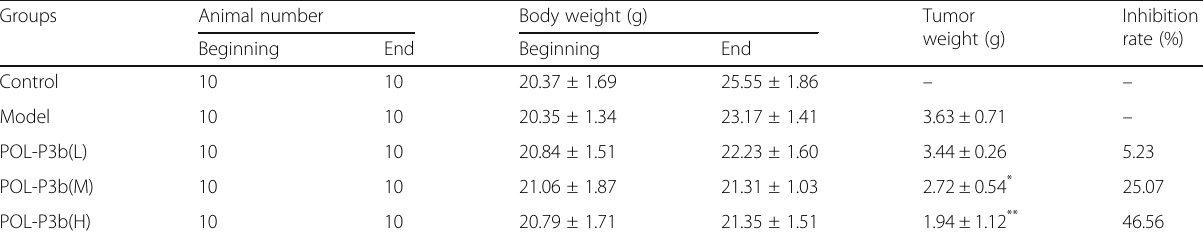
Table 1 Effect of POL-P3b by oral administration on tumor growth and weight of U14-bearing mice ( x ±S.D)